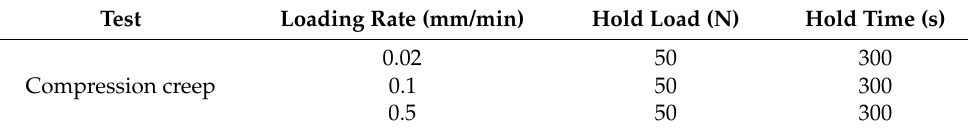
Table 3. Parameters of compression creep test.